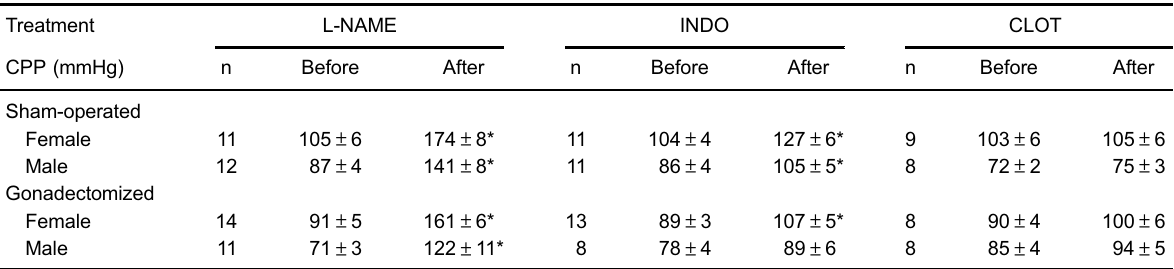
Figure 3. Relaxation responses to bradykinin ( A and B ) and sodium nitrite ( C and D ) in the coronary vascular beds of the sham-operated and gonadectomized female and male rats before and after endothelium removal. Data are reported as means ± SE; n=8 animals in each group. *P o 0.05 compared to the sham-operated females, and + P o 0.05 compared to the same group under control conditions (before endothe- lium removal, A ) (two-way ANOVA and Tukey ’ s post hoc test).